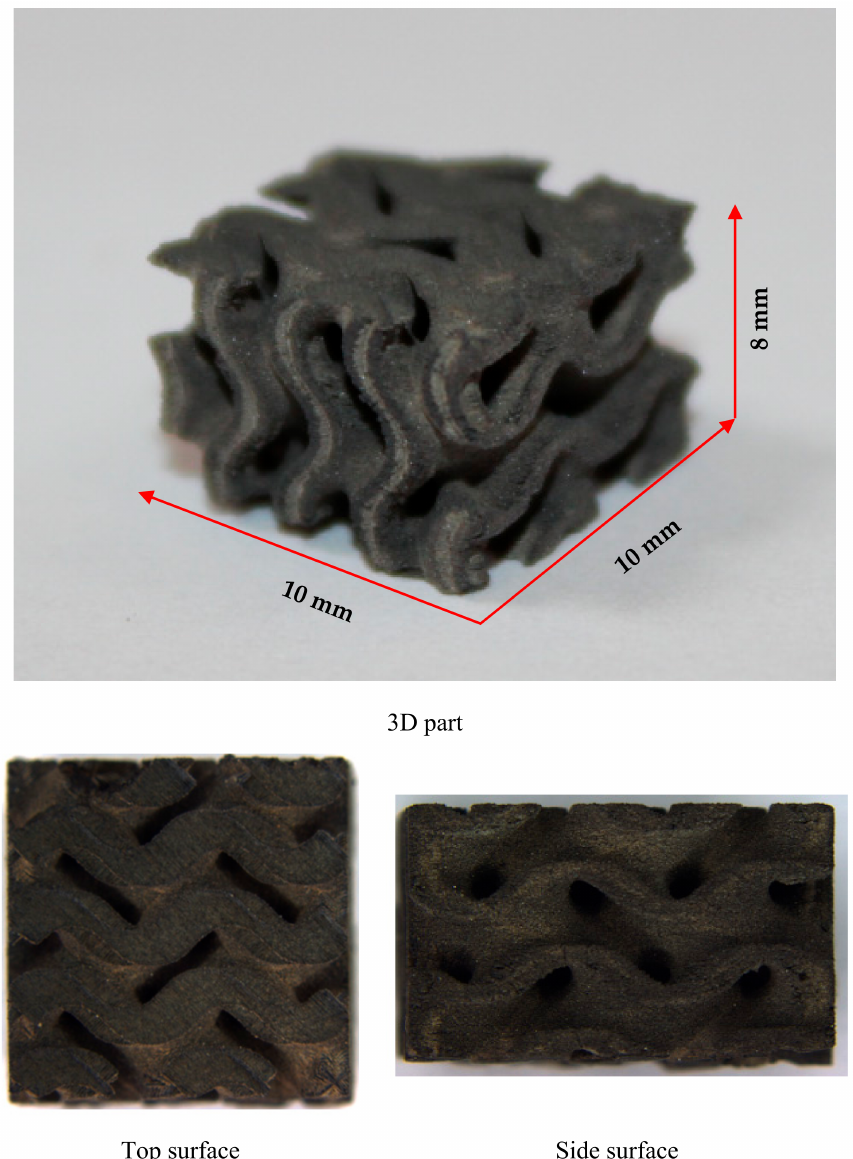
Figure 18. Triple periodic minimum surface (Gyroid) printed using the optimized process